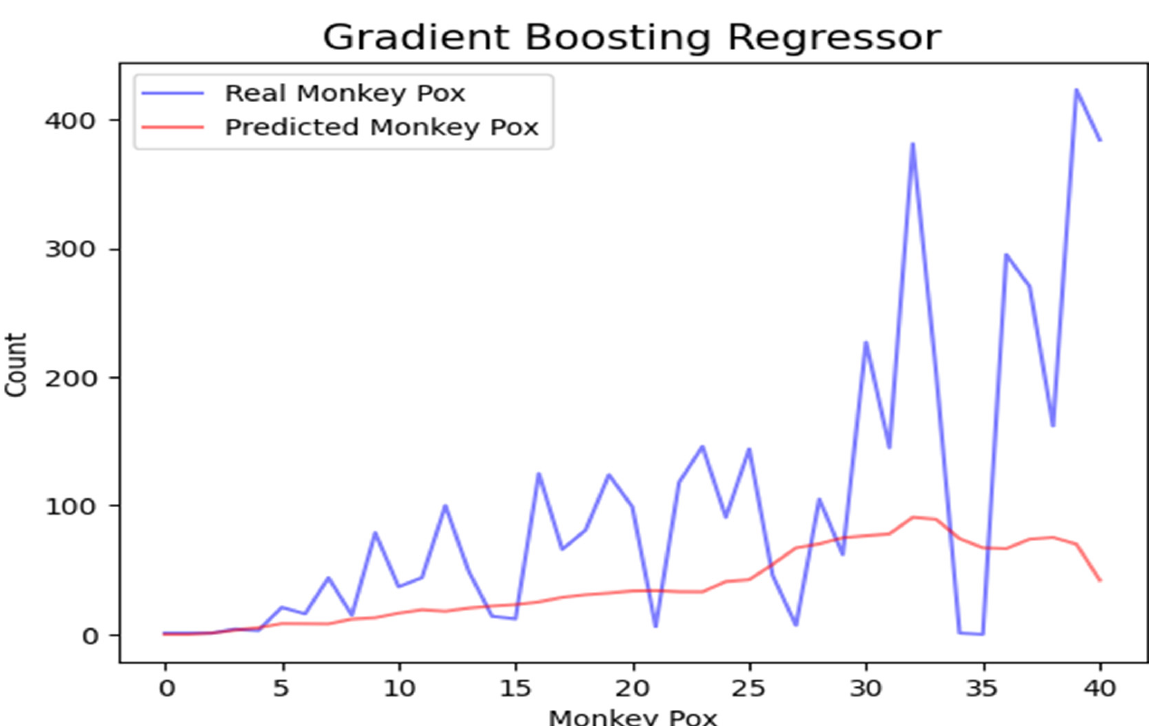
Figure 9. Time Series of Adaboost machine learning.